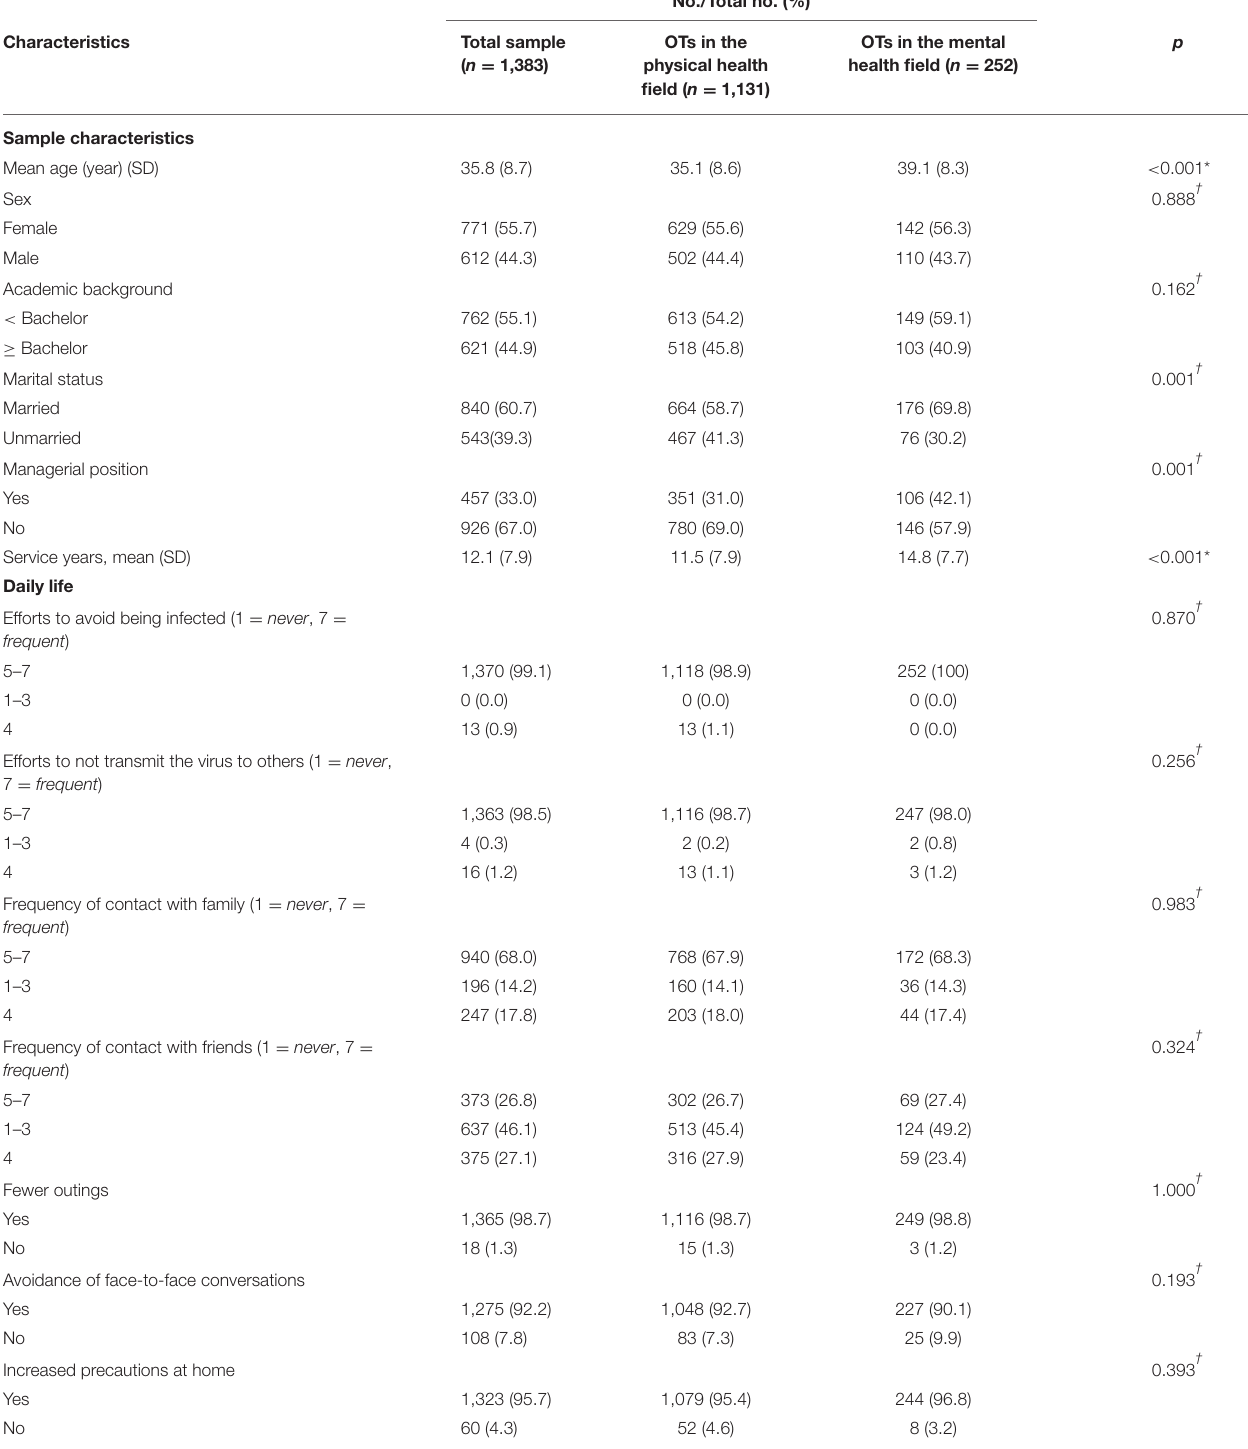
TABLE 1 | Sample characteristics and questionnaire results regarding daily